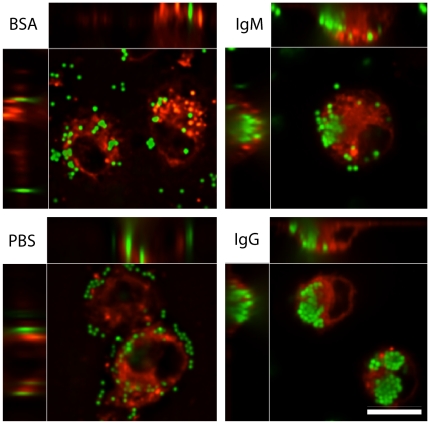
Confocal microscopy images show that macrophages internalize large numbers of human IgG- and IgM-coated beads.Confocal images show that macrophages internalize only a few BSA- or PBS-coated beads (1 µm); these beads are primarily bind to macrophages. In contrast, macrophages effectively internalize large numbers of IgG- and IgM-coated beads. Most of these beads are found as 3-D masses within the macrophages. Top and left strips in each panel show different views (X, Y, Z) of the same cells at a confocal plane. Scale bar is 10 µm.